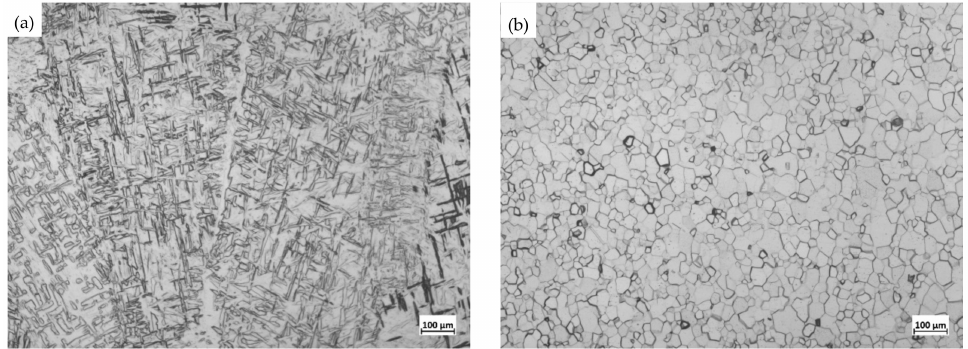
Figure 3. Microstructure comparison of the weld zone (WZ) and the base metal (BM). ( a ) Weld zone (WZ); ( b ) Base metal